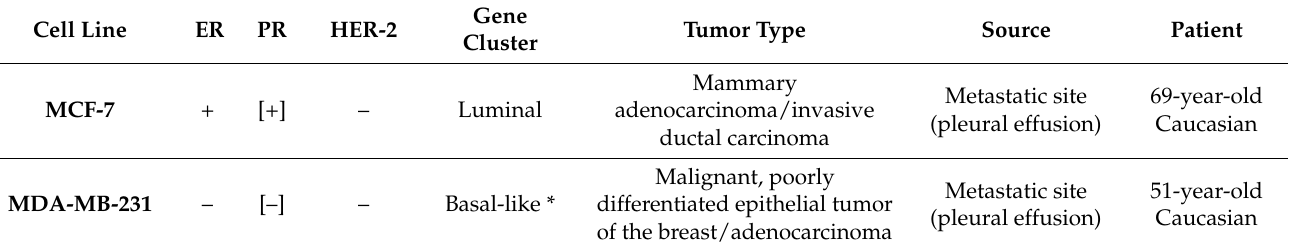
Table 1. Characteristics of the human breast carcinoma cell lines MCF-7 and